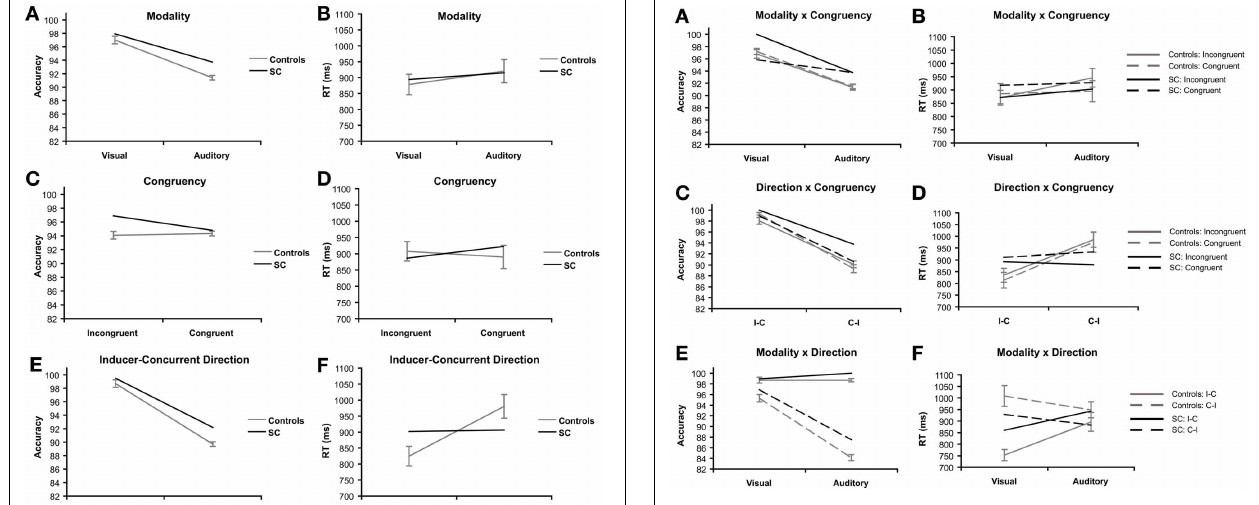
FIGURE 3 | Priming task: main effects of synesthete SC and controls ( N = 16). Main effects are plotted for three factors of interest: modality refers to the visual or auditory presentation of the stimuli. Effects of modality are presented for accuracy (A) and reaction time (B) . Congruency refers to whether the type of tastes of the prime and target words were congruent (e.g., sweet–sweet) or incongruent (e.g., sweet–sour). Effects of congruency are presented for accuracy (C) and reaction time (D) . Direction refers to whether the prime and target words were presented in SC’s inducer-concurrent (I-C) direction or concurrent-inducer (C-I) direction. Effects of inducer-concurrent direction are presented for accuracy (E) and reaction time (F) .